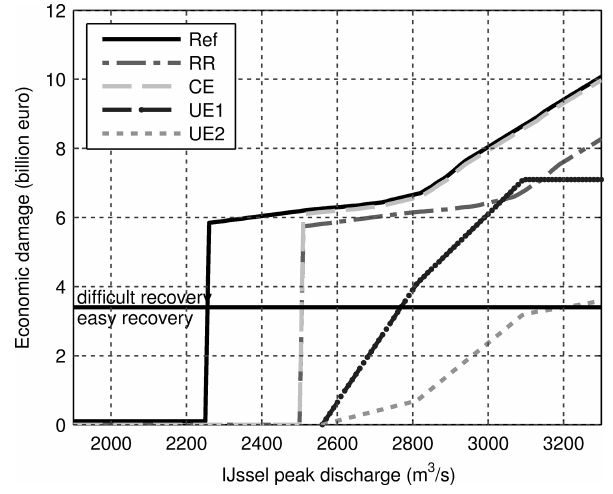
Figure 8. Response curves for reference system and alternative con-